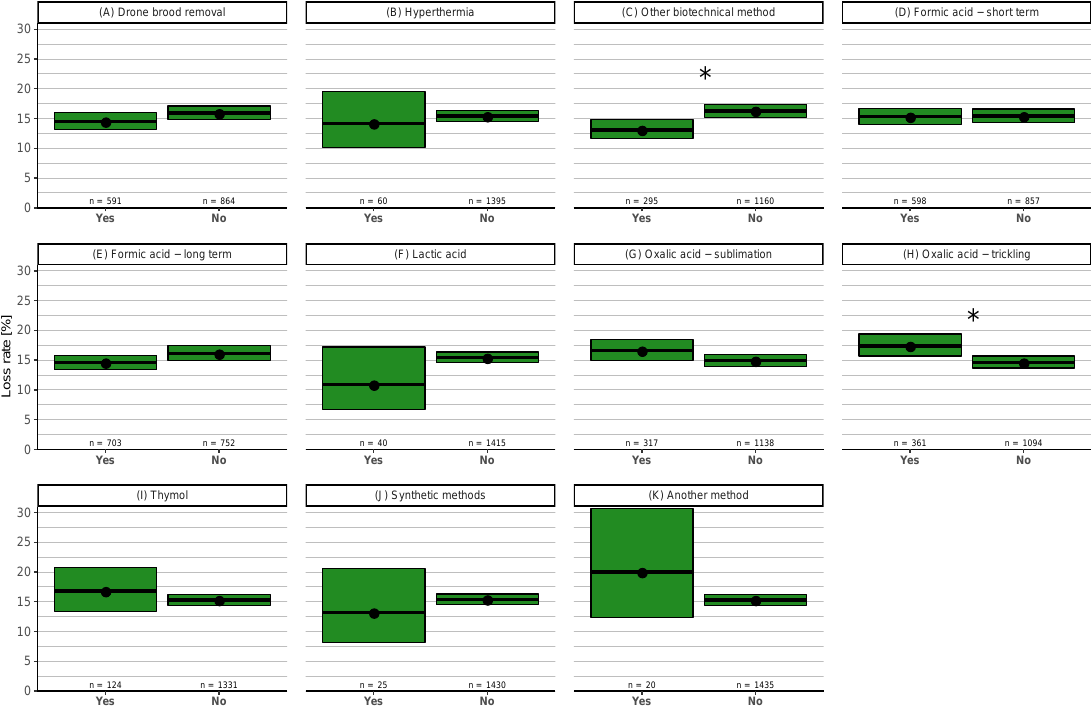
Figure A2. Treatment methods (yes = n > 19) used in spring 2018 (April–May) as single factors to winter honey bee colony loss rates (and 95% CI): To improve sample size, the oxalic mixture was added to oxalic trickling.